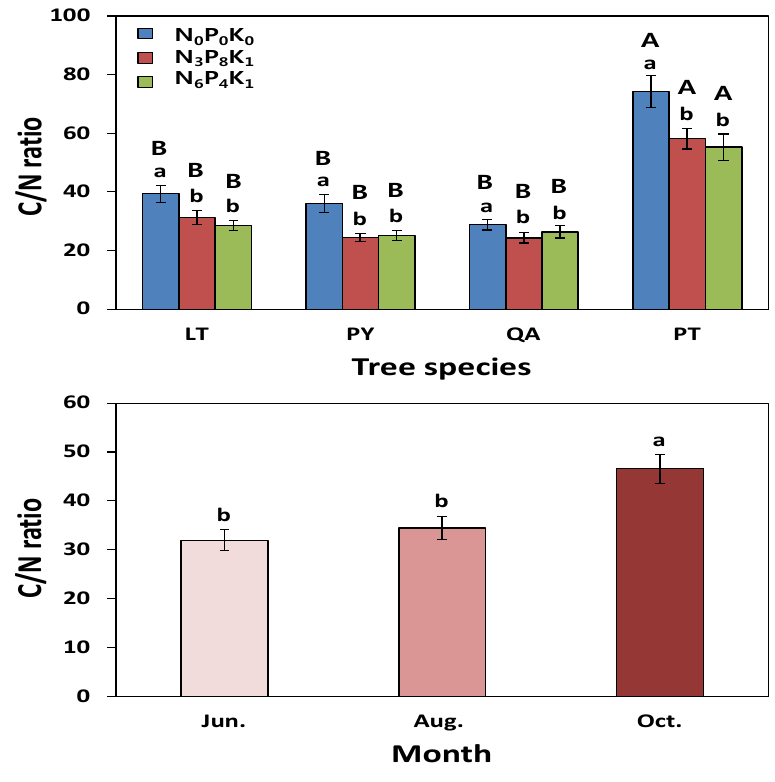
Figure 6. Carbon and nitrogen ratio of foliage by tree species and sampling month in a fire-disturbed urban forest (mean ± standard error). Treatment means with the same lower case letter among fertilizer or sampling month treatments and treatment means with the same upper case letter among tree species are not significantly different at p <